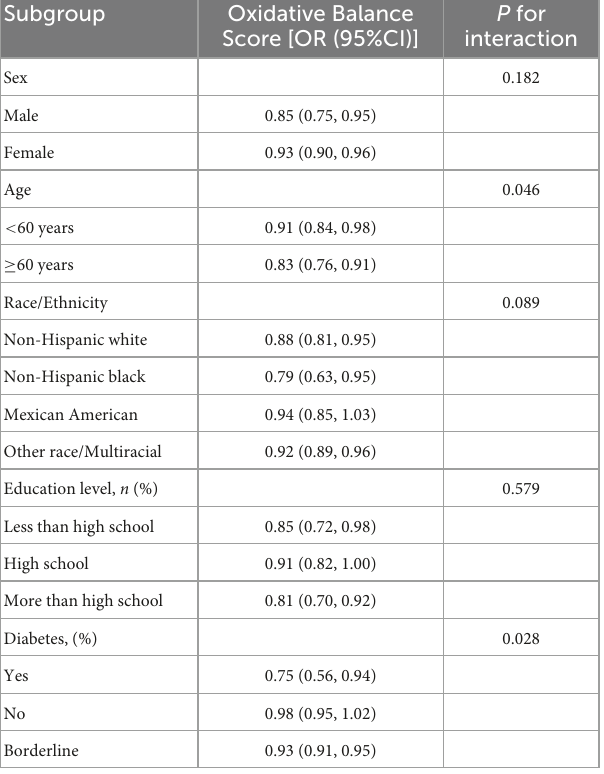
TABLE 4 Subgroup analysis of the association between Oxidative Balance Score and